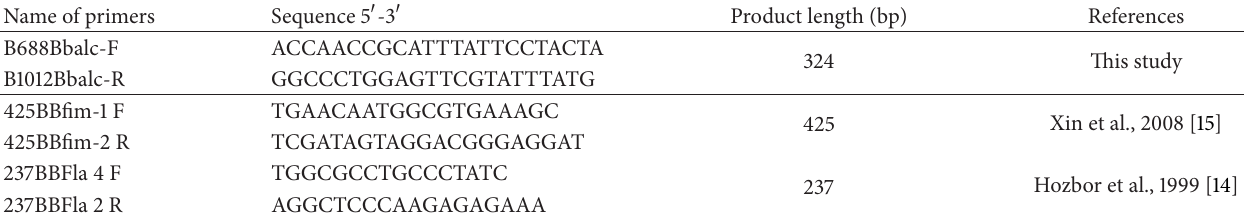
Table 3: Genus specific and species specific primers used in multiplex PCR for detection of Bordetella